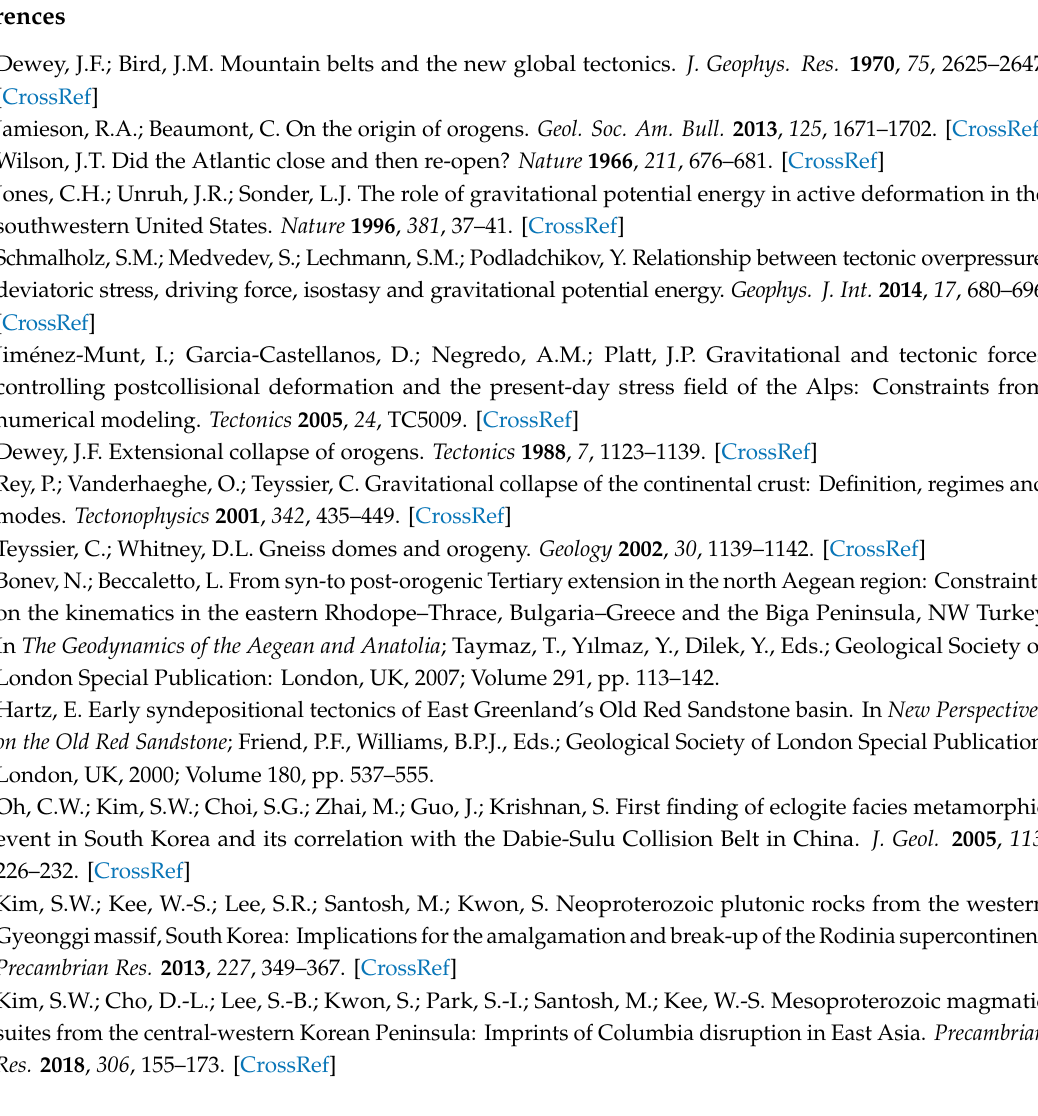
Table S1: SHRIMP U-Pb isotopic data of zircons from a deformed felsic tu ff in the Deokjeok Formation. Table S2: LA-MC-ICP-MS U-Pb isotopic data of zircons from a mylonitized porphyritic granite in the Soya Shear Zone and a deformed quartz porphyry in the Deokjeok